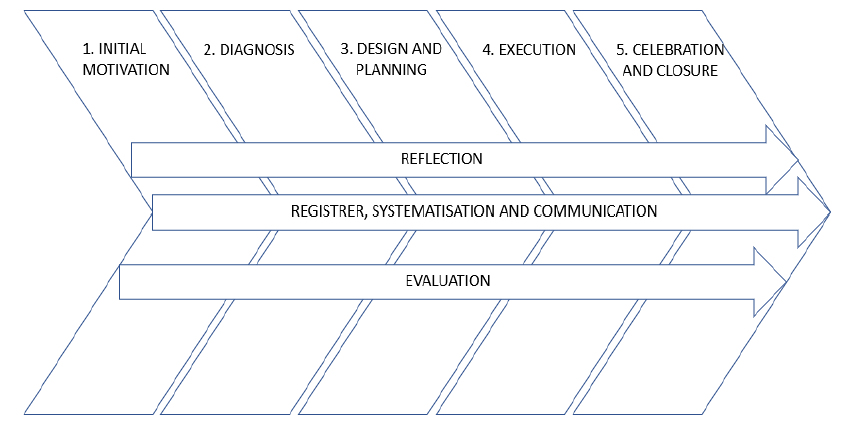
Figure 1. CLAYSS (2016) model phases.